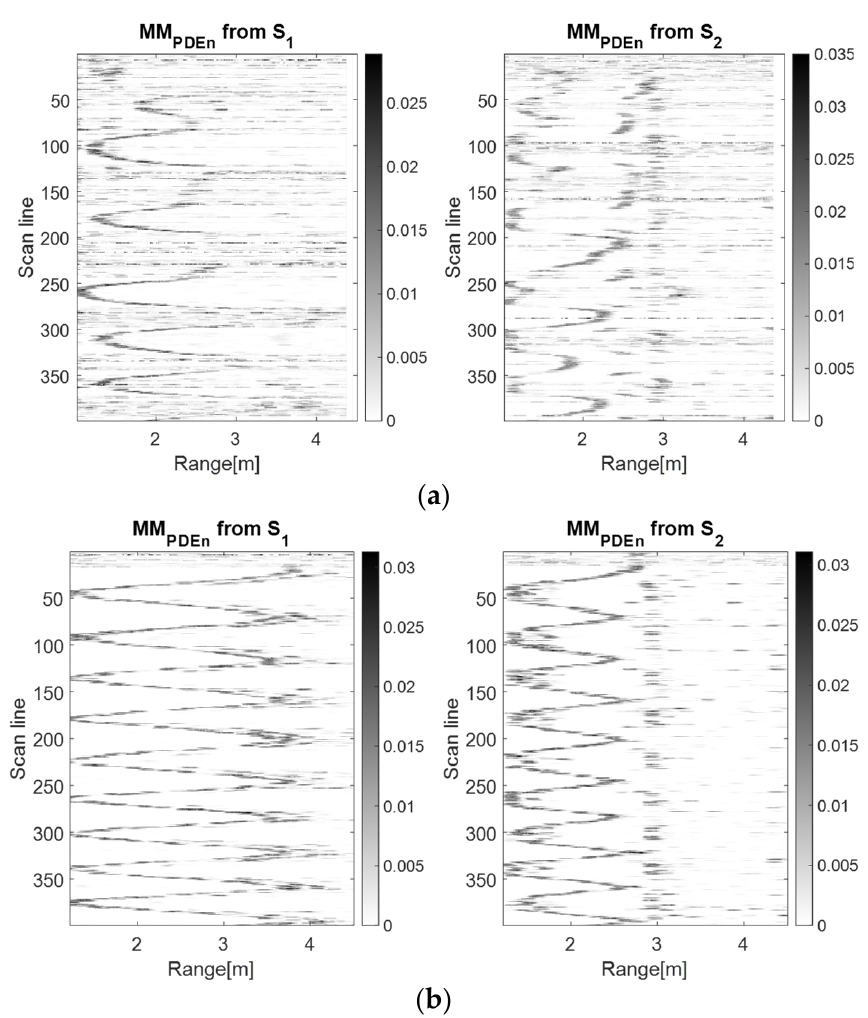
Figure 7. The drone ( a ) and the human ( b ) forward–back movement maps using the PDEn method with m = 5, d = 1, σ = 0.71.